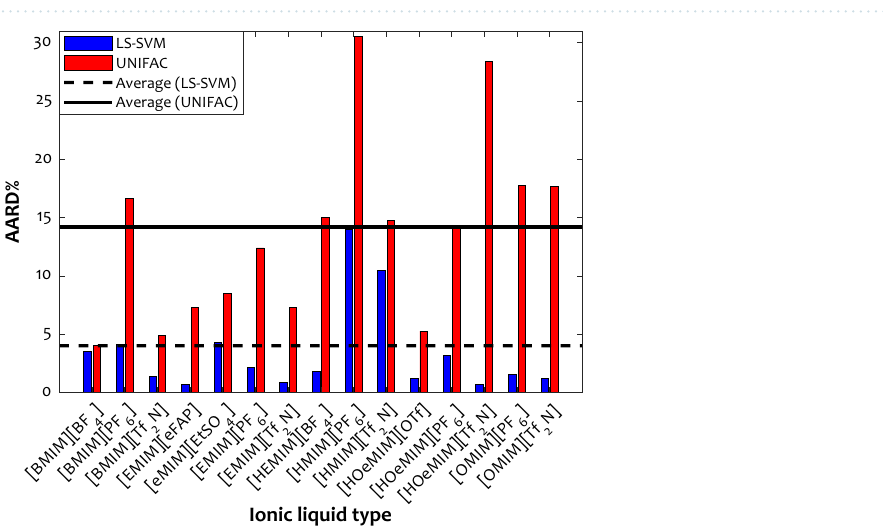
Figure 6. Histograms of the residual errors (RE) of the LS-SVM for predicting H 2 S solubility in different IL media ( a ) training group, ( b ) testing group, and ( c ) all datasets.